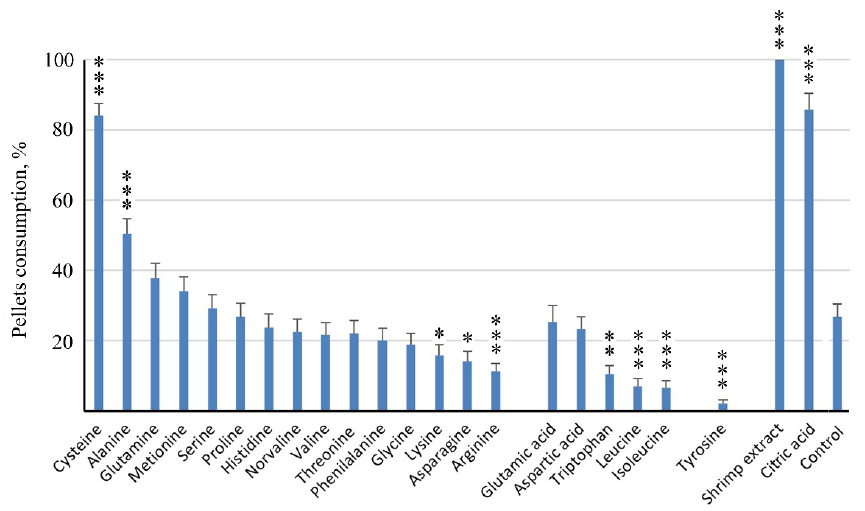
Figure 3. Palatability of agar gel (2%) pellets flavored with L-amino acids and shrimp Penaeus van- namei water extract, 300 g (wet weight)/L for barramundi Lates calcarifer juveniles. The concentrations are 0.1 M for all substances except glutamic acid, aspartic acid, leucine, isoleucine and tryptophan (0.01 M), and tyrosine (0.001 M). *, **, and ***—differences from the control are significant at p < 0.05, p < 0.01, and p < 0.001, respectively ( χ 2 -test). Whiskers are the s.e.m.